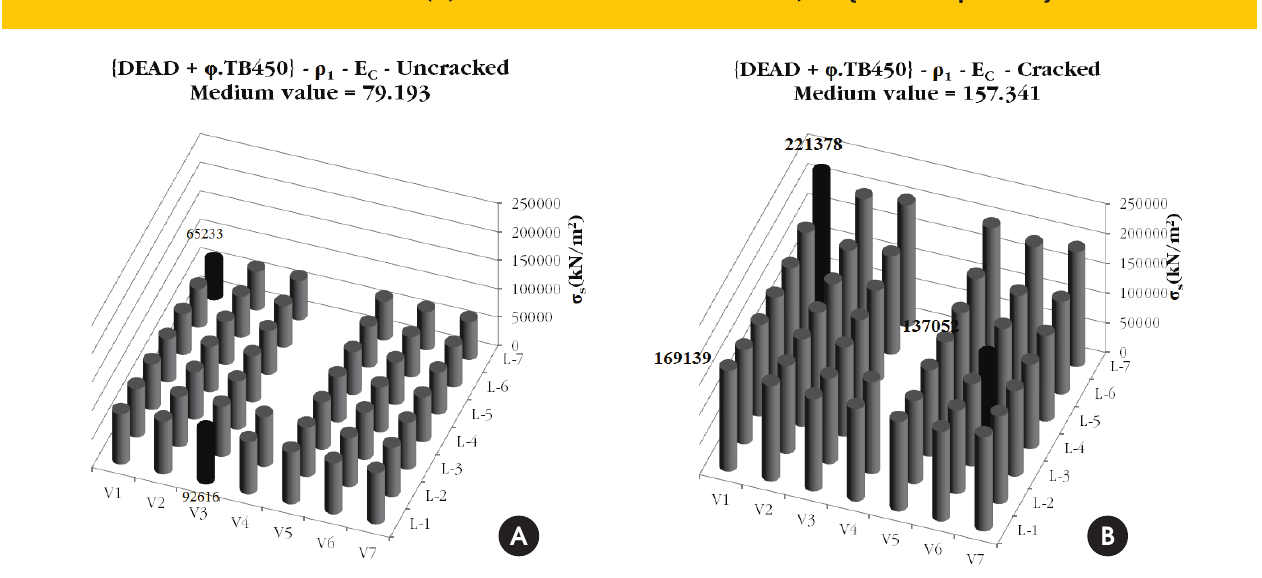
Figure 22 – Distribution of the stress on the reinforcement bars in uncracked section (a) and in the cracked section (b) for the solid element model, for {DEAD + φ .TB450}